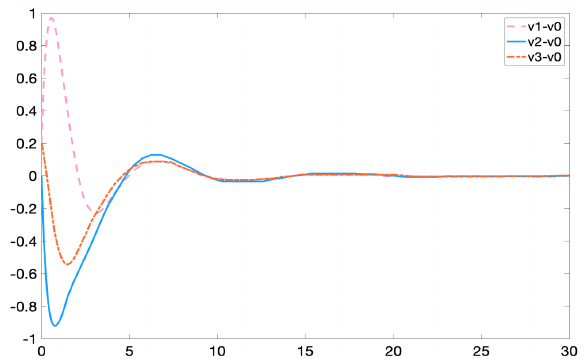
Figure 7. Errors between the Speed of Three Followers’ Hanging Points and the Speed of Leaders’ Hanging